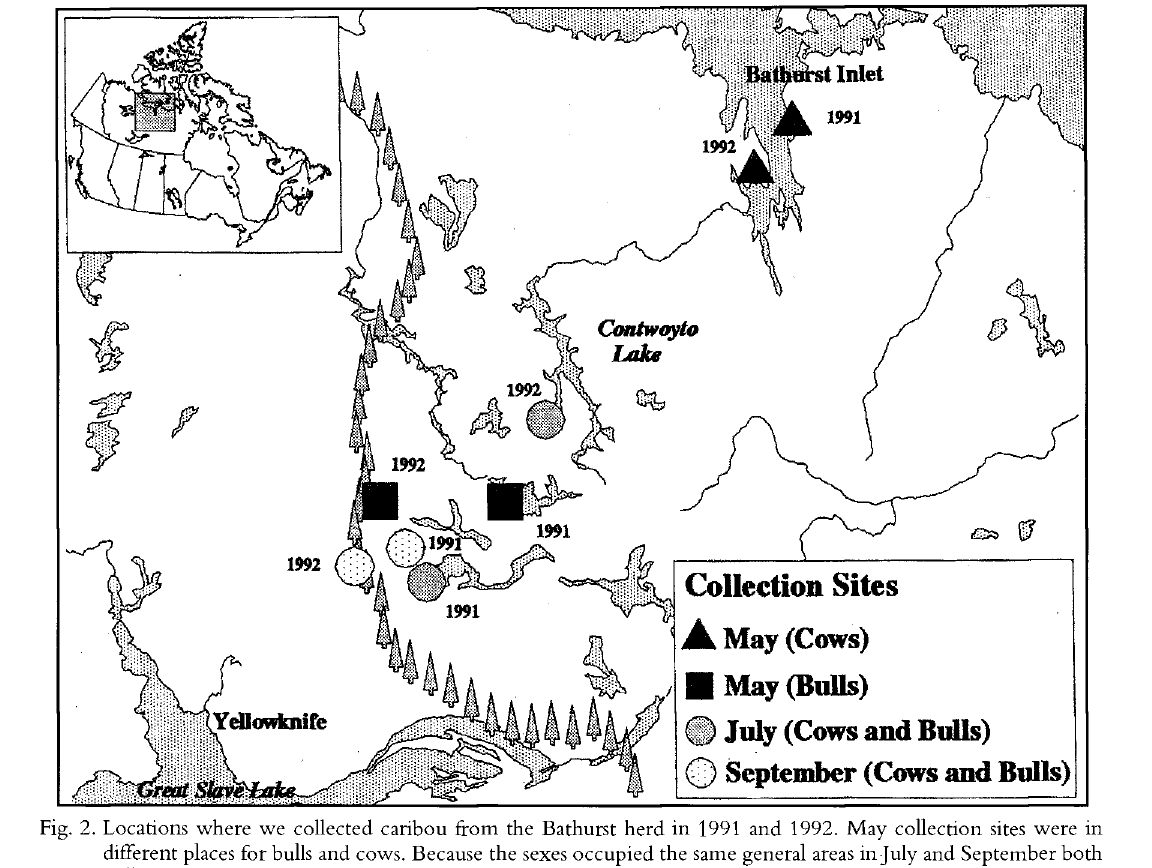
Fig. 2. Locations where we collected caribou from the Bathurst herd in 1991 and 1992. May collection sites were in different places for bulls and cows. Because the sexes occupied the same general areas in July and September both bulls and cows could be collected at the same site.